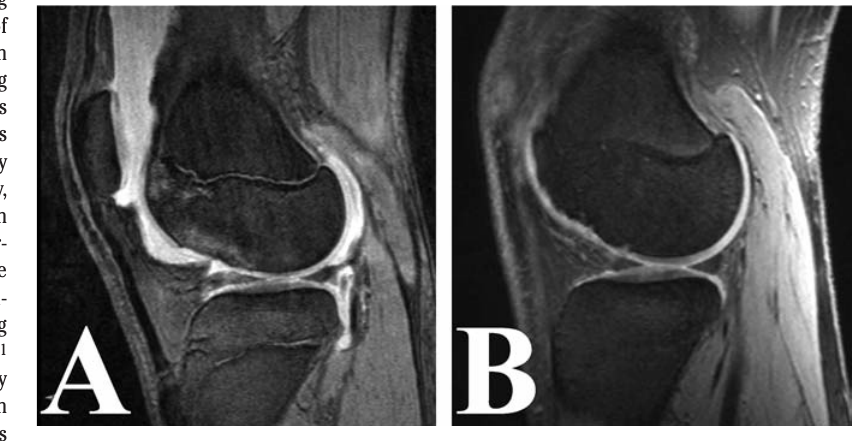
Figure 1. (A) Pre-operative magnetic resonance imaging (MRI) shows large fresh traumat- ic chondral lesion of the lateral femoral condyle in a 15-year old boy with open physis. (B) 14-month postoperative follow-up MRI regression of bone marrow edema and satis- fying cartilage defect fill with well shouldered border integration and almost isointense cartilage signal. Irregularities remain within the subchondral